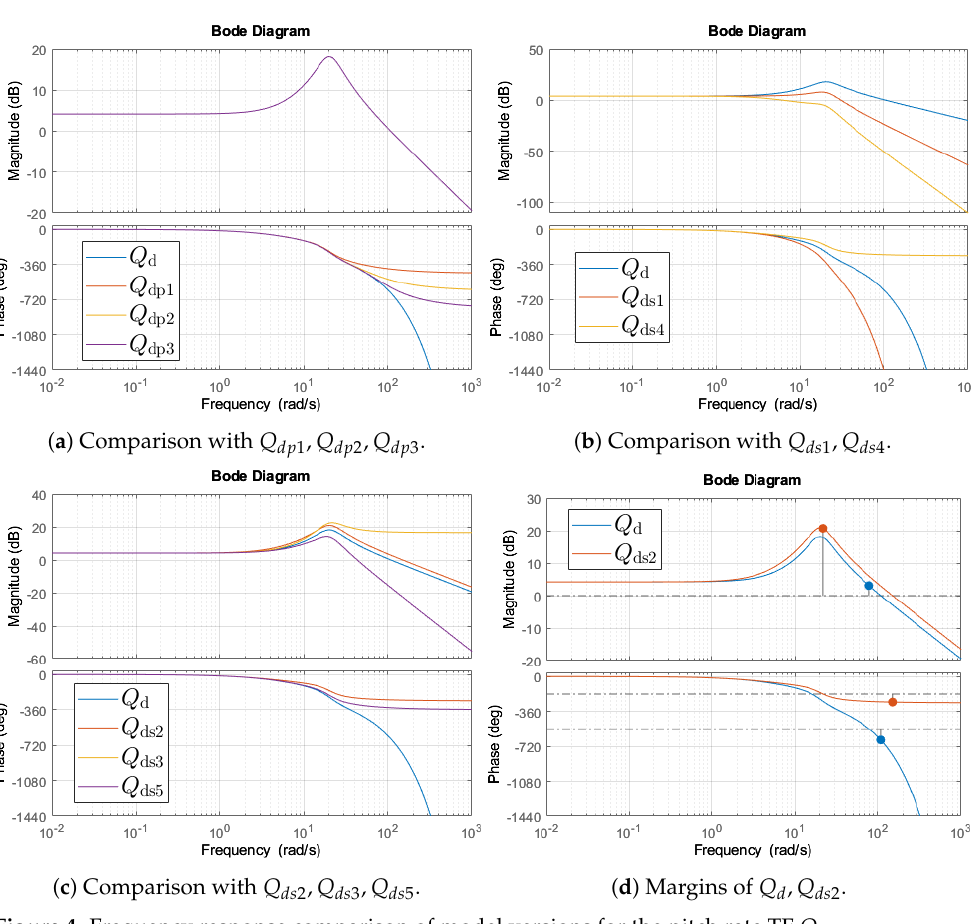
Figure 4. Frequency response comparison of model versions for the pitch rate TF Q d